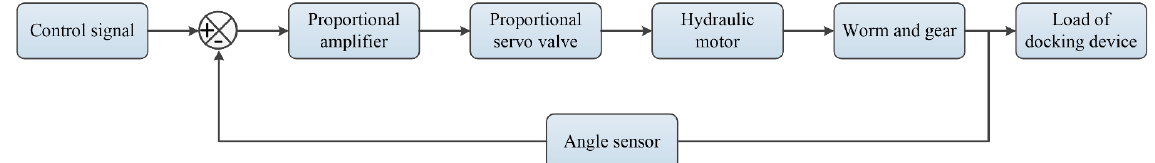
Figure 6. Control schematic diagram of heading angle adjustment circuit.